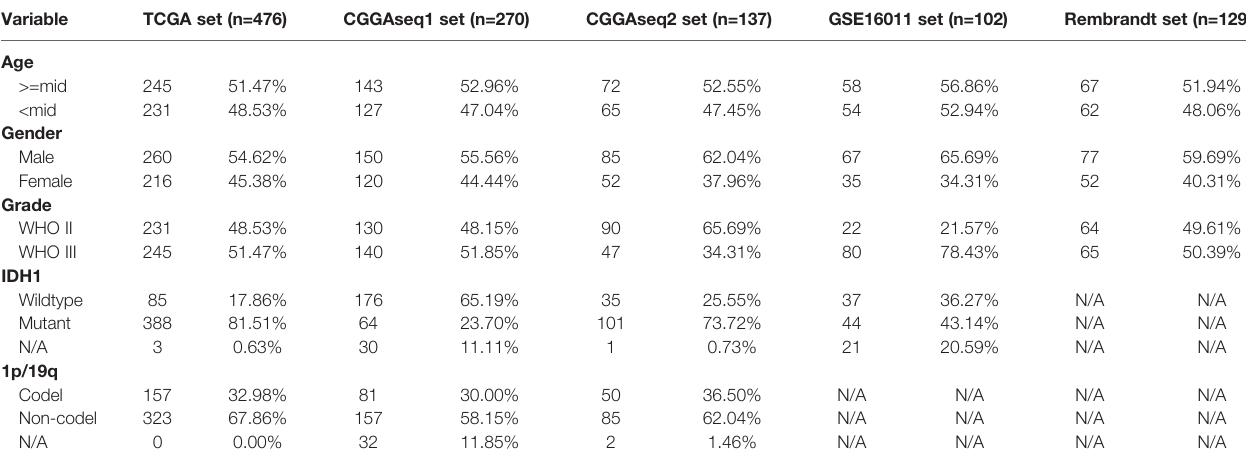
TABLE 1 | The basic information for primary low-grade glioma (LGG) patients in the TCGA, CGGAseq1, CGGAseq2, GSE16011, and Rembrandt datasets.